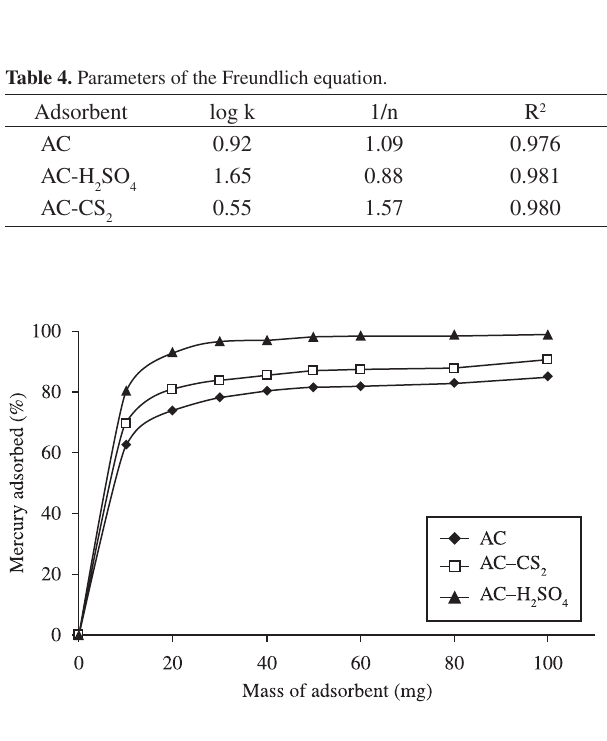
Table 3. Acid and basic surface groups and pH Adsorbent